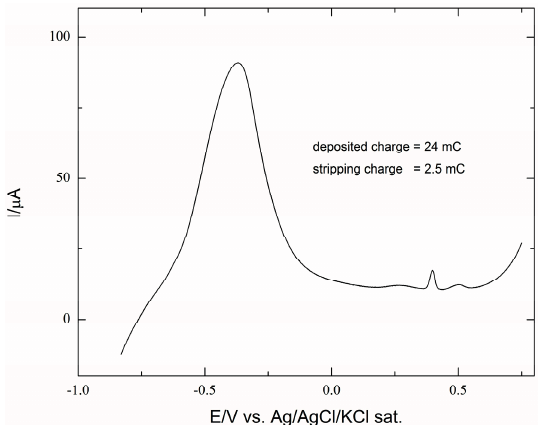
Figure 2. Stripping voltammetry of a Co deposit of 24 mC (equal to 9.3 μ g·cm − 2 ) as recorded by scanning the potential from − 0.8–+0.8 V at a scan rate of 10 mV s − 1 . The small peak at +0.4 V can be associated with the formation of Co(III).